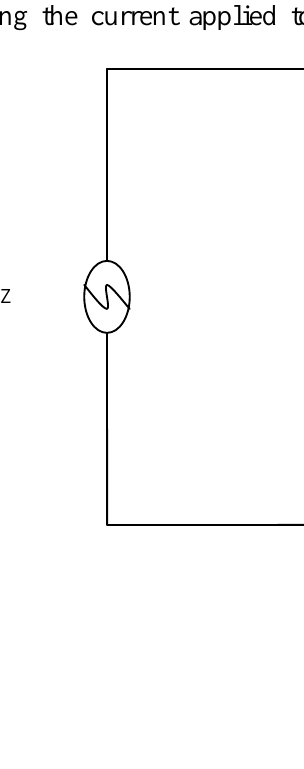
Fig.1: Schematic diagram of the experimental